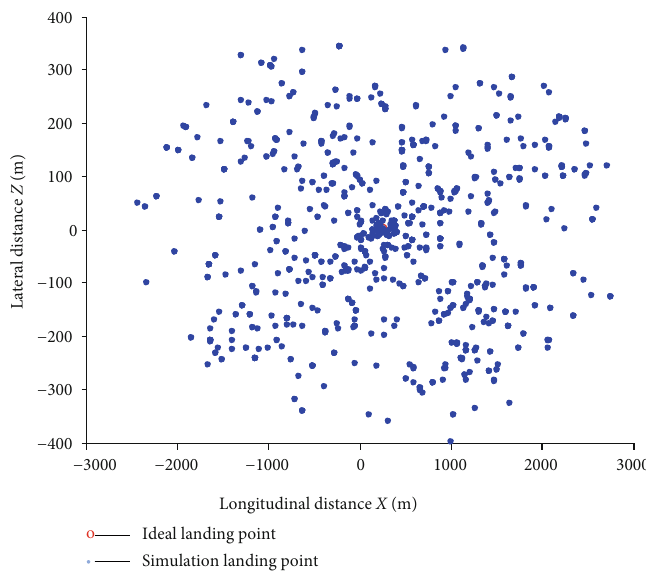
Figure 9: Scattering map of the fall